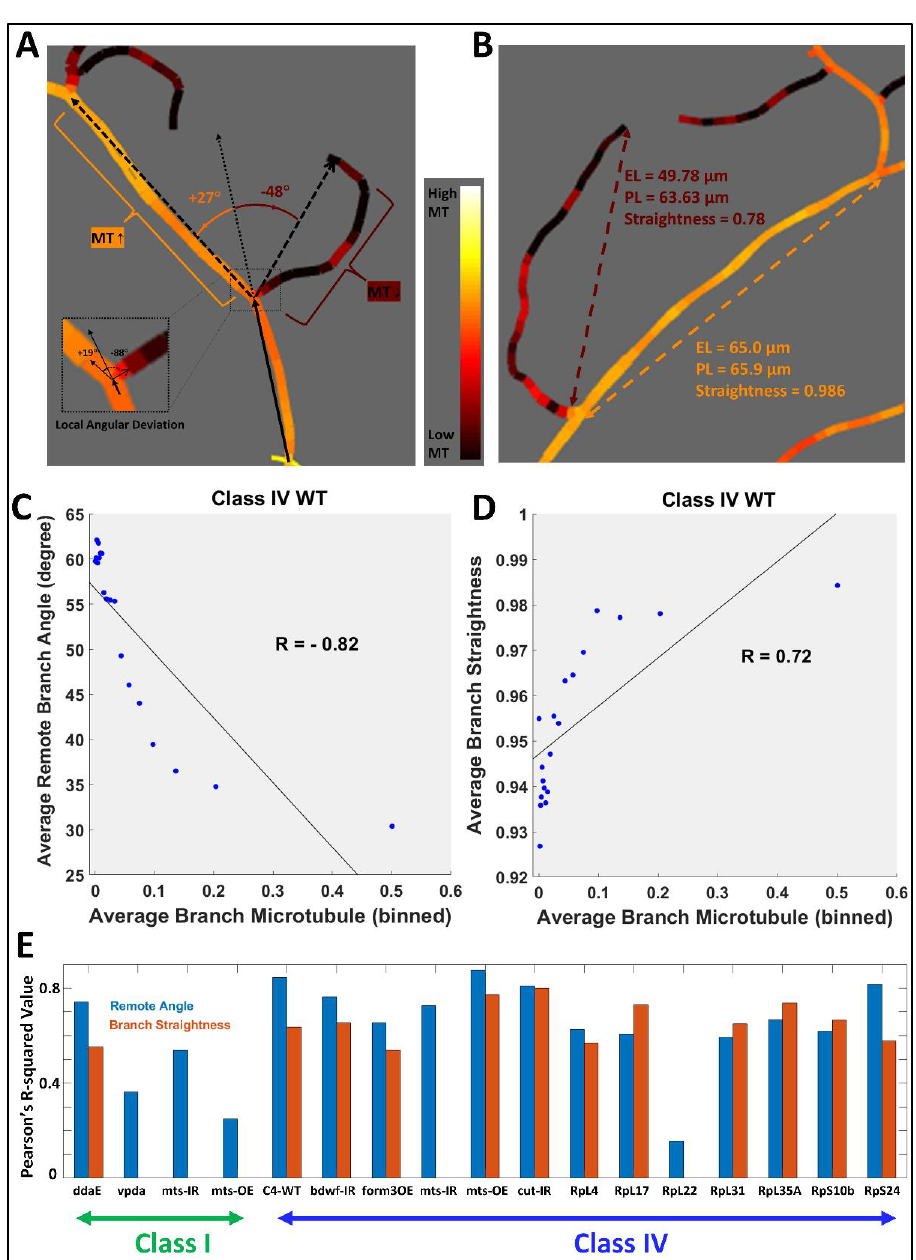
Figure 2. Branch Angular Deviation and Straightness. ( A ) Schematic illustration of remote angular deviation (inset: local angular deviation) in counterclockwise (positive sign) and clockwise (negative sign) direction. The branches with lower average microtubule have greater angular deviations. ( B ) Schematic illustration of branch straightness (ratio of branch Euclidean length to branch path length). The branches with higher average microtubule are straighter. ( C ) Binned scatter plot of average remote branch angle against average branch microtubule quantity of Class IV WT neurons demonstrates a negative correlation. ( D ) Binned scatter plot of average branch straightness against average branch MT quantity of Class IV WT neurons demonstrates a positive correlation. ( E ) Coefficients of determination of branch MT with branch remote angle (blue) and straightness (orange). Class I vpda WT and mutants show no correlation between MT quantity and branch straightness. See Table 1 for sample size by cell type.